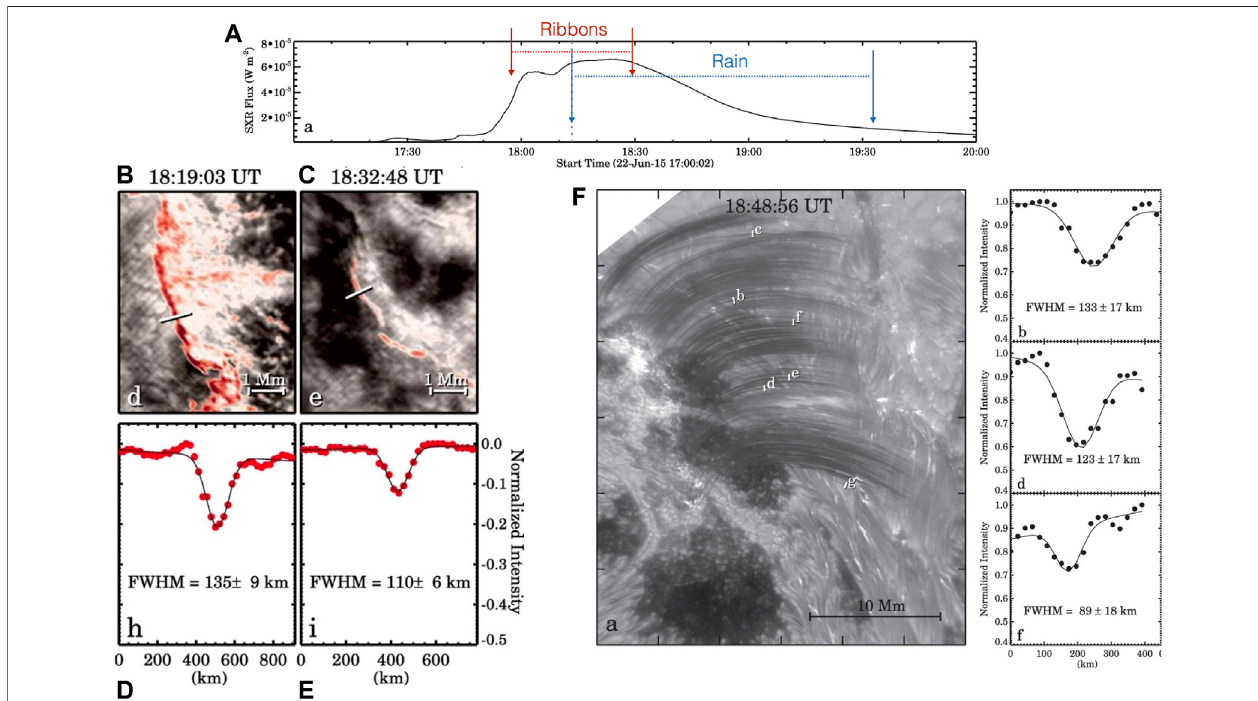
FIGURE17| Fine structure produced byasolar fl areobservedinH α withthe NST , reportedbyJing etal.(2016). (A) showstheGOES soft X-ray1 – 8Å lightcurve, where the temporal location of the fl are ribbons (in red) and the fl are-driven rain (in blue) are indicated. (B – E) show the ribbon in H α at 2 instances in time. The intensity along a cut across the ribbon (in white) is shown in the bottom panels, with the respective FWHM values from the fi ts. (F) , a snapshot of the H α FOV is shown during the gradualphase,wheretheraincanbeseeninabsorption.Theintensitiesandtherespective fi tsalongseveralcutsacrossthestrand-likerainstructureareshownon the (F) . Note that the FWHM values of the rain widths match the widths of the ribbons. Adapted from Figures 1, 2 and 3 of Jing et al.